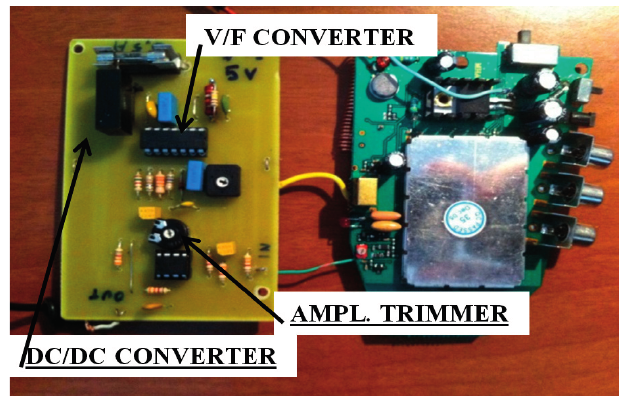
Figure 5. Prototype of the receiver